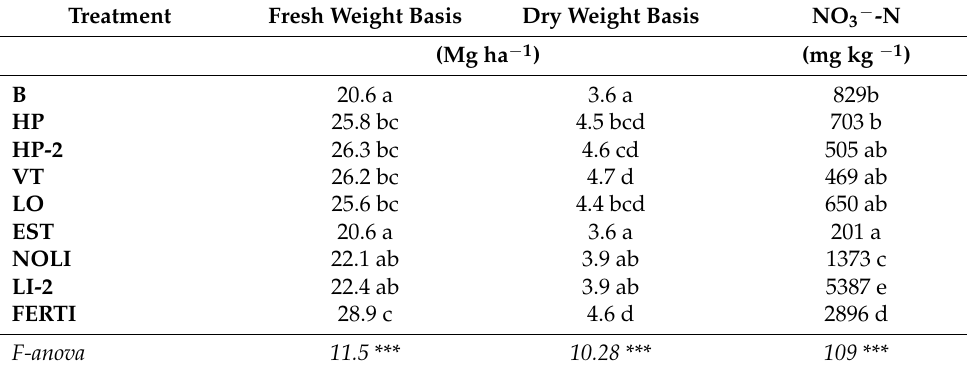
Table 5. Dill yield according to